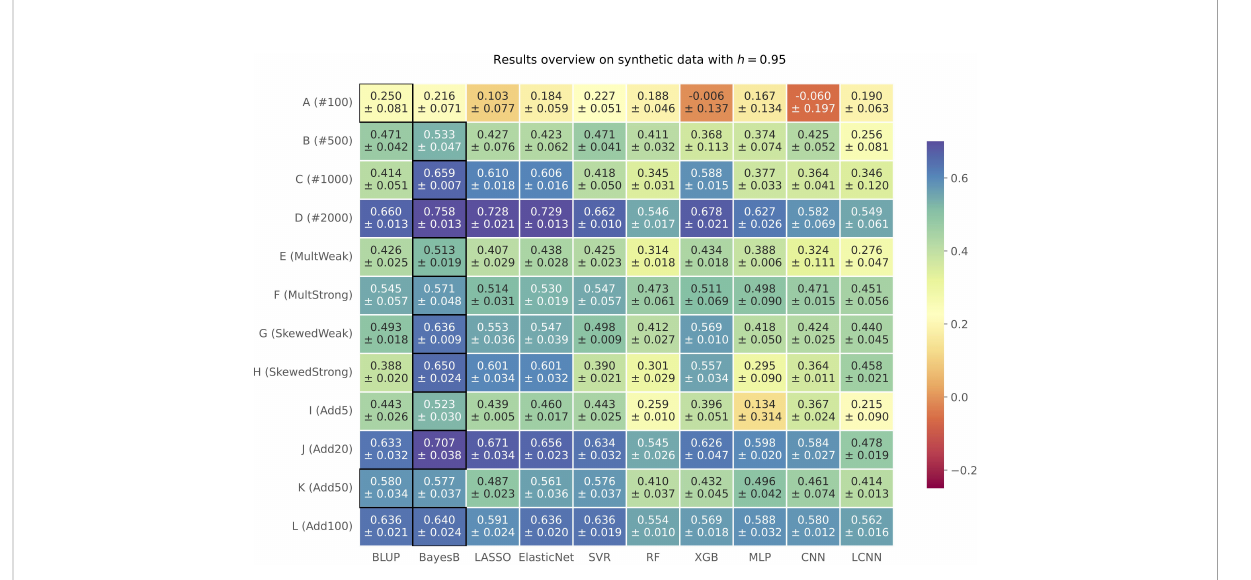
FIGURE 1 Results on synthetic data with h =0.95 shown in a heatmap: Each cell gives the explained variance v that the prediction model given on the horizontal axis achieved for the simulation con fi guration speci fi ed on the vertical axis. The color of each cell ranging from dark red to dark blue represents the prediction performance. The best result for each simulated phenotype is highlighted by a black frame around the